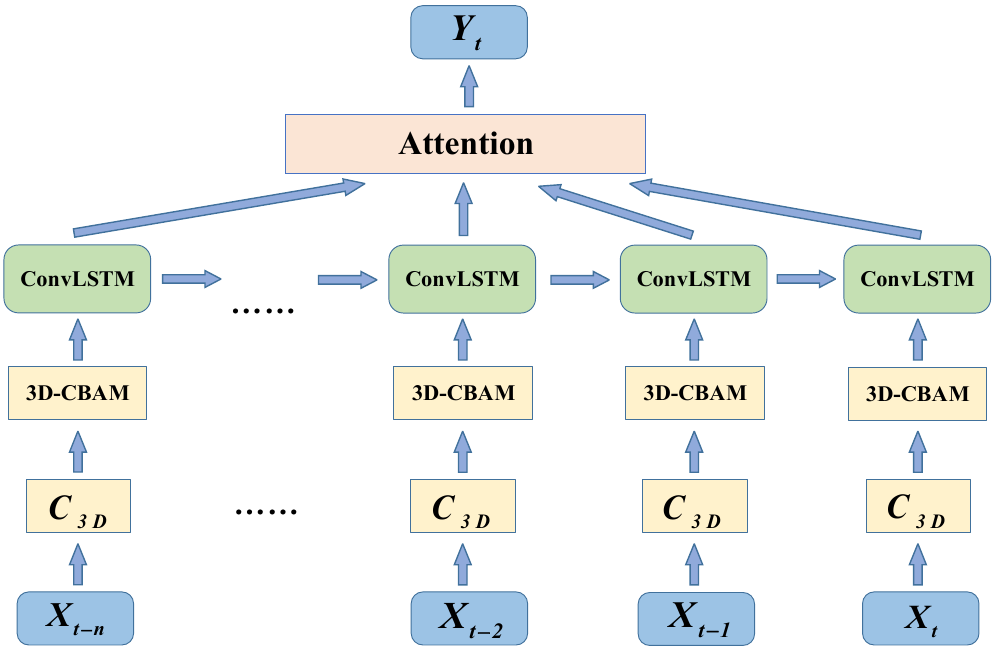
Figure 2. The framework of 3DCBAM-ConvLSTM method.